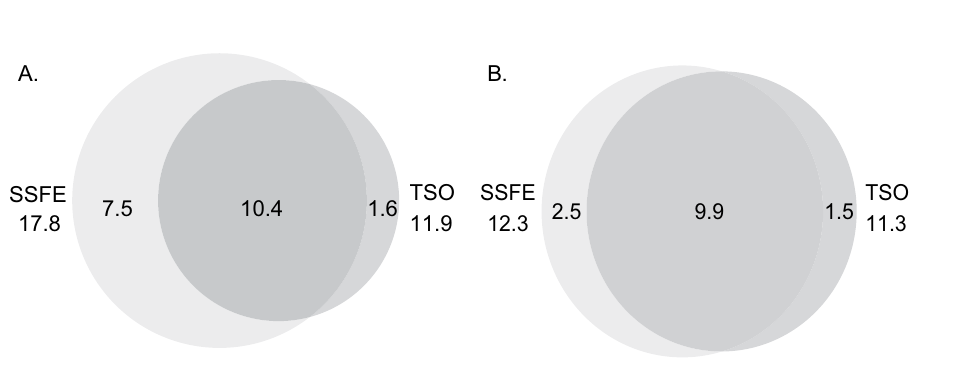
Table 1. Summary coverage statistics for triplicate sequenced samples. a Coefficient of variation. b Target regions as defined by vendor target BED file.